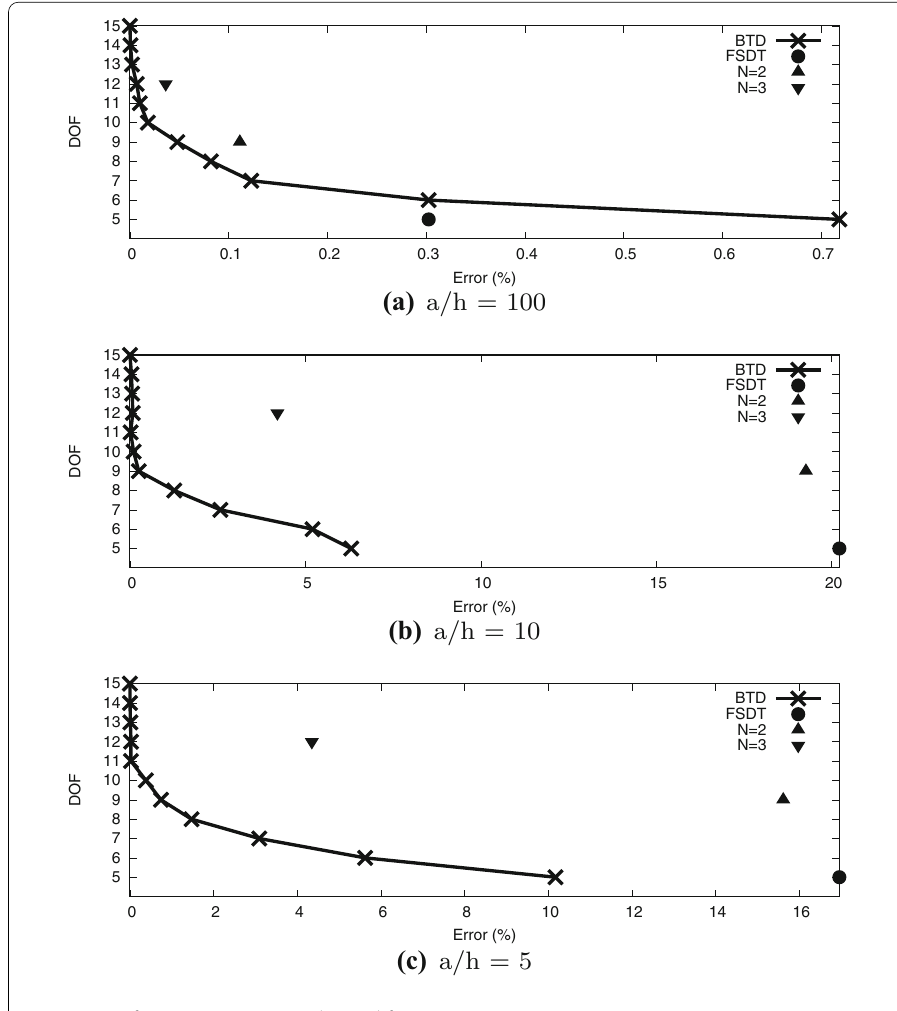
Fig. 10 BTD for 0/90/0/90, R/a = 5,